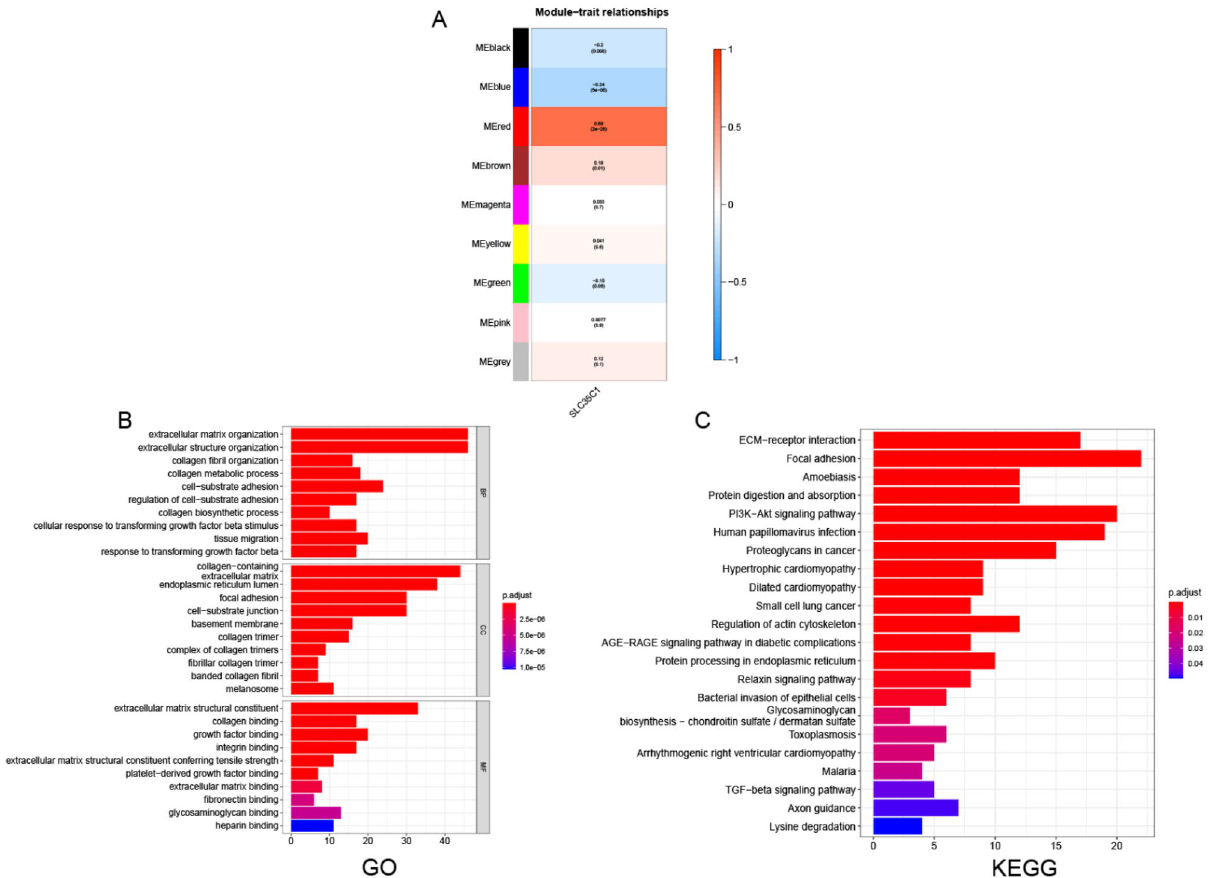
Figure 11. Association of SLC35C1 expression with WGCNA in glioma. ( A ) Module trait relationship (p-value) for detected modules (y-axis) in relation with traits (x-axis) for glioma. The relationships were colored based on the correlation between the identified module and traits. The color scale on the right demonstrate module-trait relationship from − 1 (blue) to one (red), where blue represents strong negative correlation and red represents a strong positive correlation. ( B ) Gene ontology (GO) and corresponding P-values are shown. ( C ) Kyoto Encyclopedia of Genes and Genomes (KEGG) and corresponding P-values are